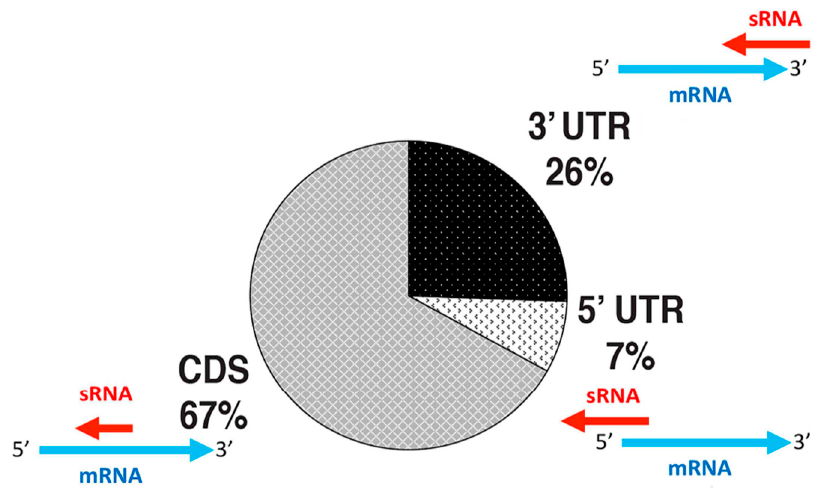
Figure 2. Distribution of binding regions for antisense sRNAs. Colors indicate type of sRNA binding [4]. CDS: coding sequence.